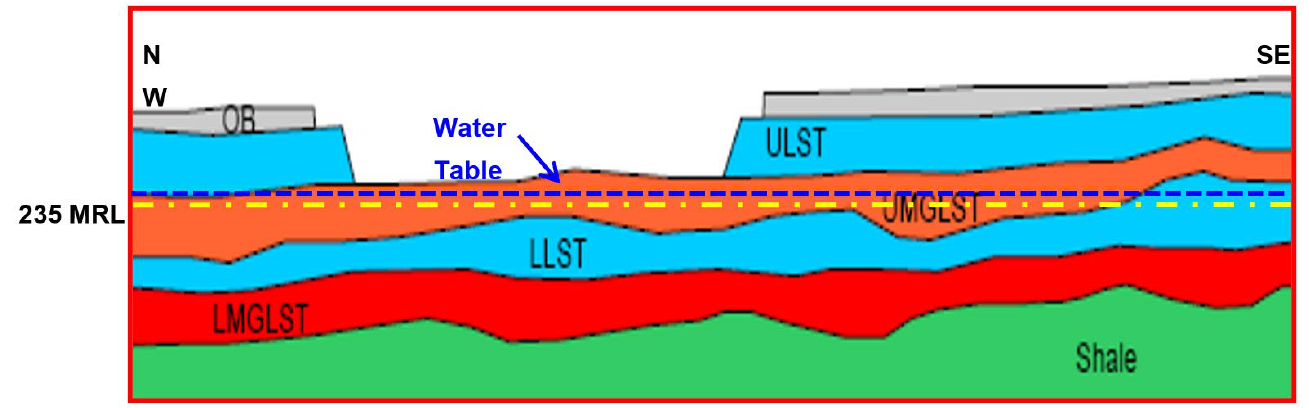
Figure 1. NW-SE section of the limestone mine.